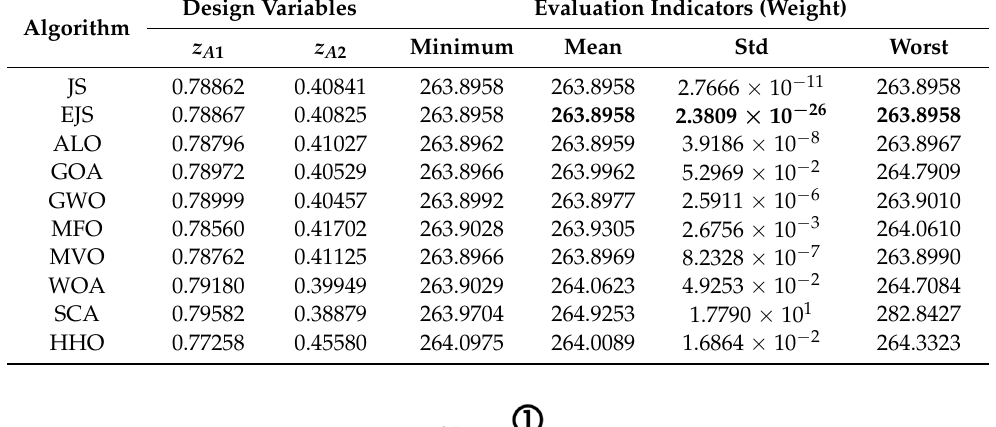
Table 10. Evaluation indicators and variable values for Figure 12.